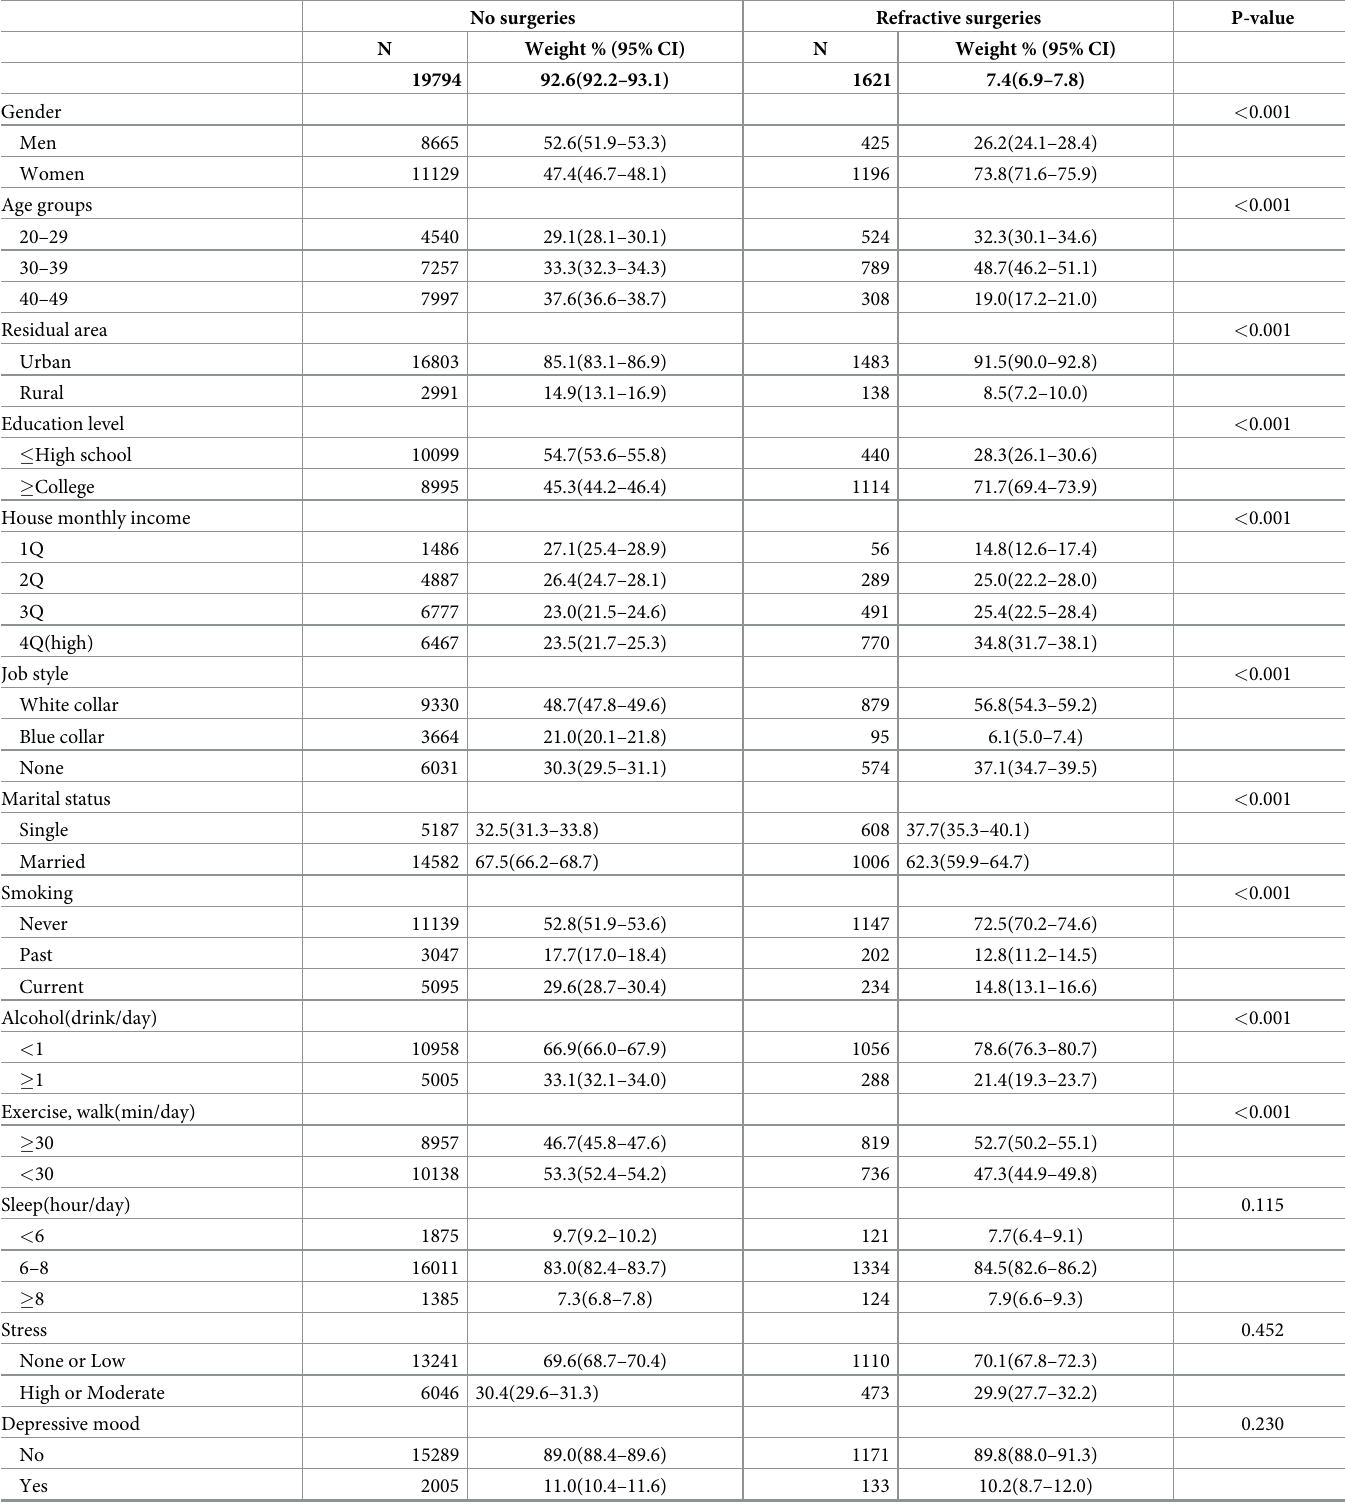
Table 1. Baseline characteristics of the study